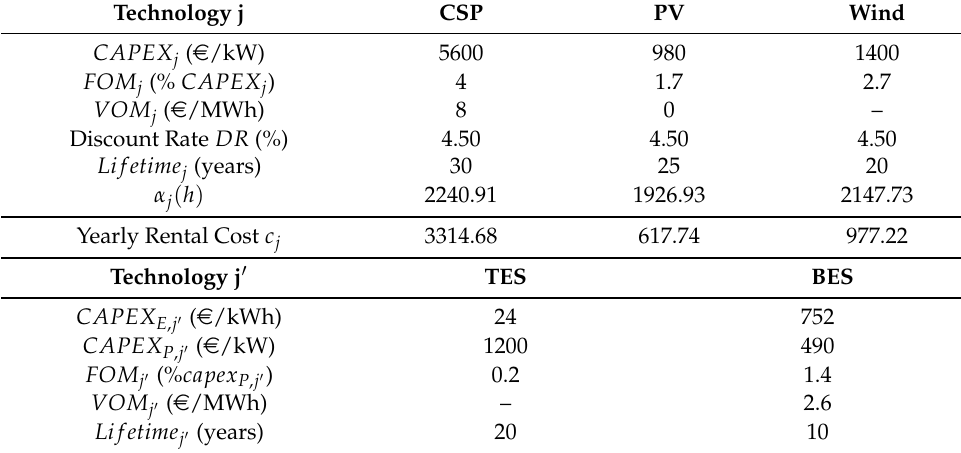
Table 3. Capital investment, fixed and variable operation and maintenance costs, lifetime of the production technologies (Top) and storage technologies (Bottom). These data are from the ETRI 2014—Energy Technology Reference Indicator projections for 2010–2050 technical report for the year 2013 ([91], Tables 4, 7 and 10) for PV, wind and CSP; and ([91], Tables 66 and 61) for TES and Li-ion BES. The discount rate was obtained from the World Bank Report ([90], p. 27), α j is the yearly- mean CF in (h) of the technology j (A9), and the yearly rental cost per technology, c j ( e /kW/yr), is calculated using Equation